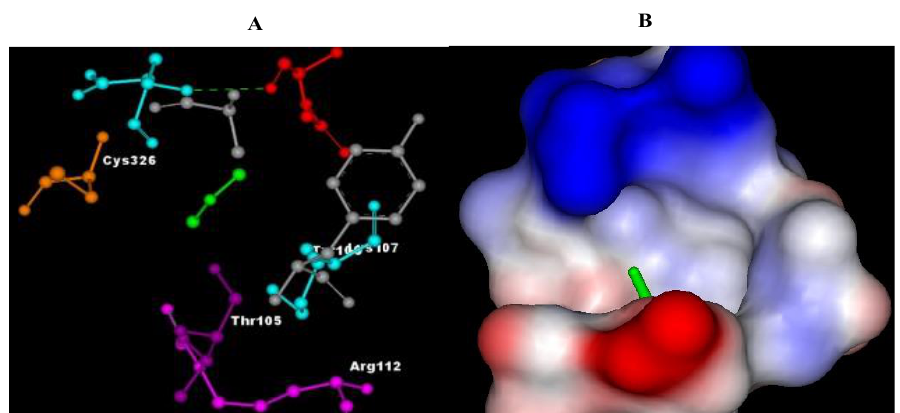
Figure 6. Pictorial representation of molecular docking analysis. ( A ) Binding orientation in the